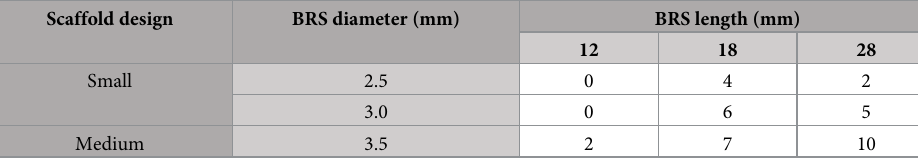
Table 5. Description of the different sizes of BRS in our study (36 stents total).